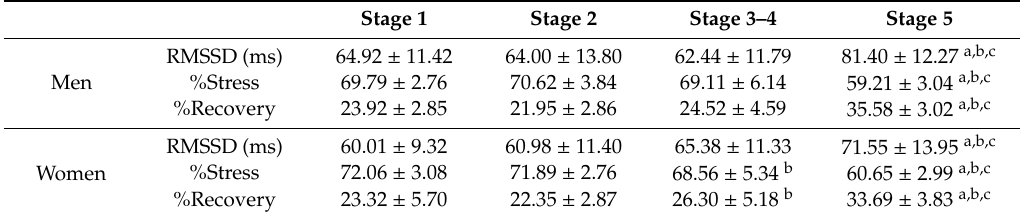
Table 2. Di ff erences in RMSSD, %Stress and %Recovery in the di ff erent TTM groups.